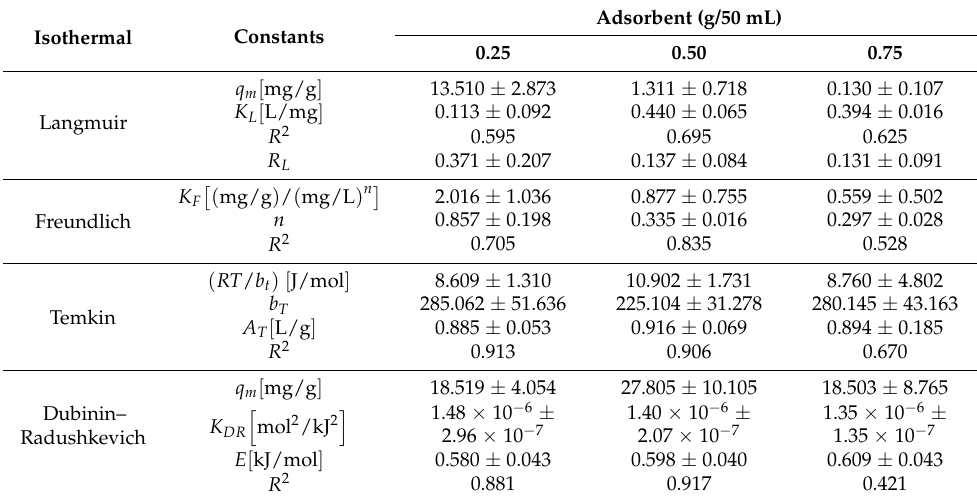
Table 6. Characteristic parameters of the adsorption isotherms model after it was fitted with the experimental data obtained with the ADY—Drimaren Yellow Dye CL-2R. Adsorbate concentration 50 mg/L. pH =